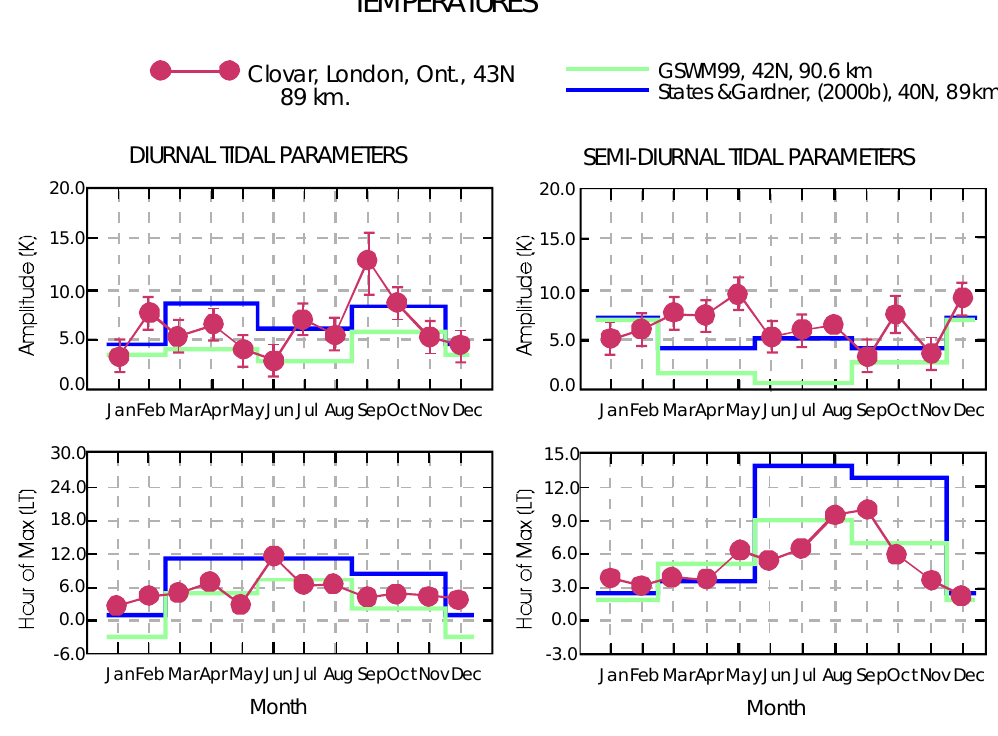
Fig. 9 Fig. 9. As for Fig. 8, but for the Clovar meteor radar at London, Ontario, Canada.